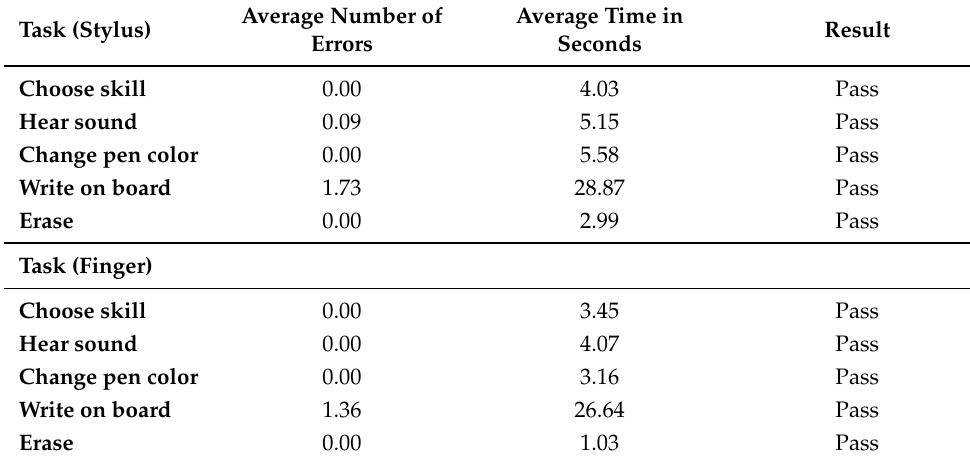
Table 7. User acceptance test for stylus and finger tasks. Task